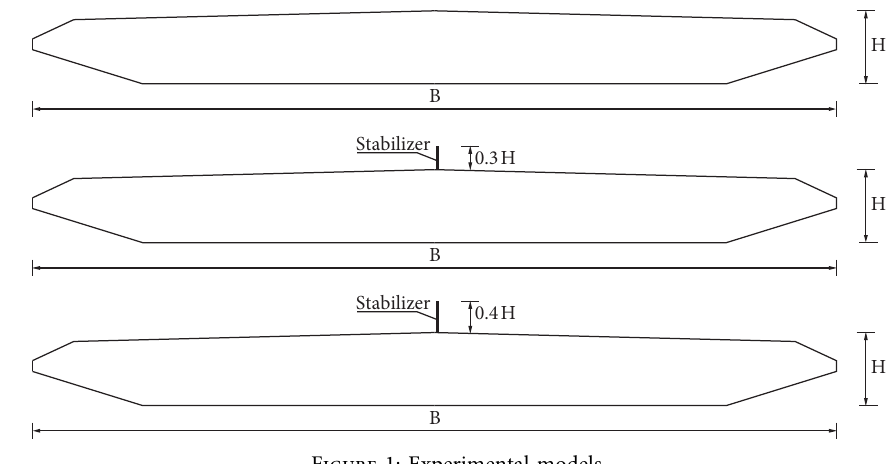
Figure 1: Experimental models.